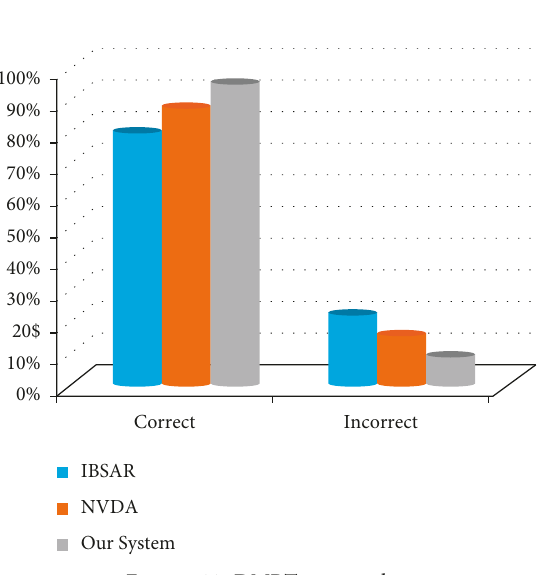
Figure 10: DRT test results.